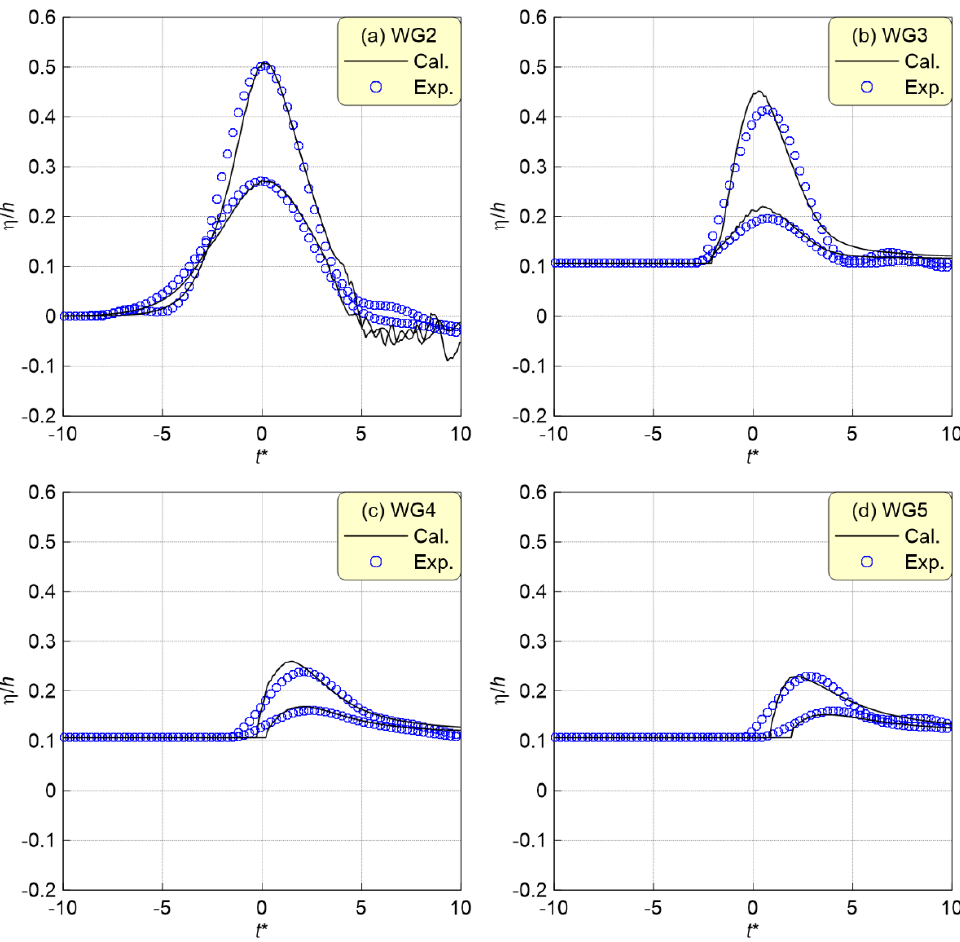
Figure 10. Comparisons of measured and calculated time-domain water surface elevations at the VR.